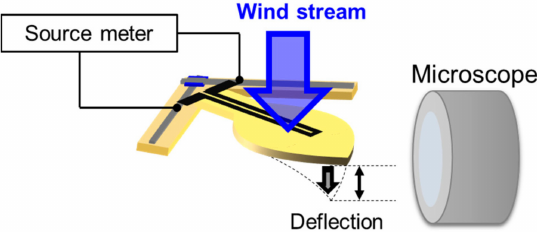
Figure 3. Measurement setup to evaluate the single sensor’s mechanical and electrical response against wind speed.